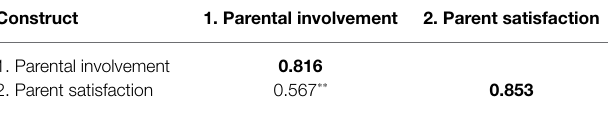
TABLE 4 | Validity of the